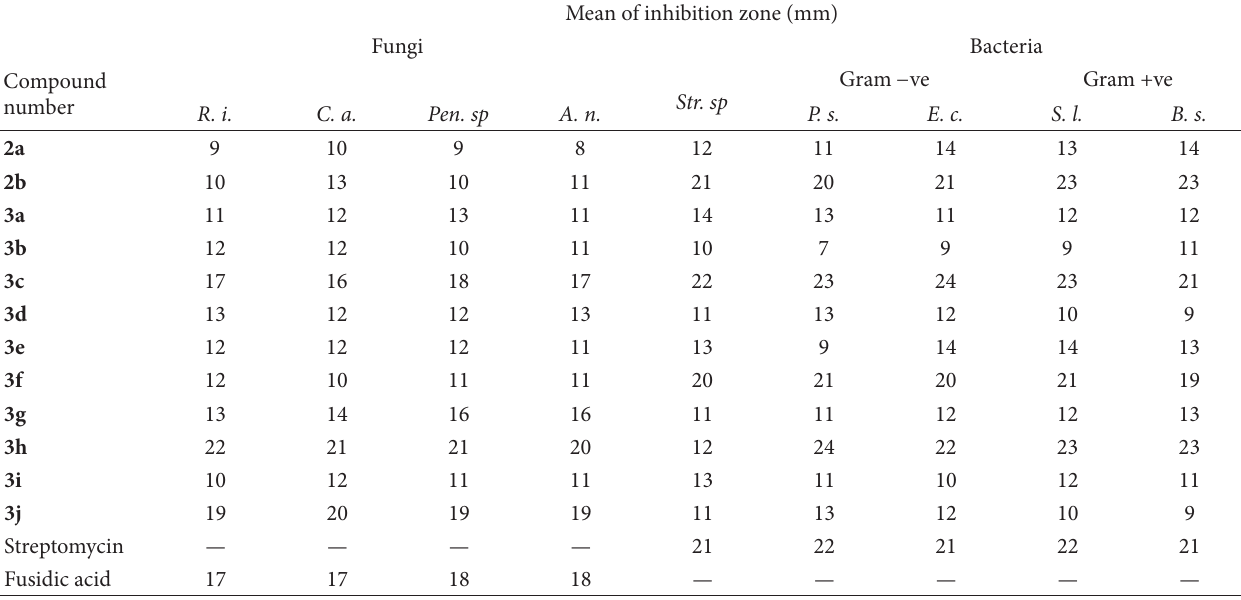
T 1: Antimicrobial activity of the newly synthesized compounds. Mean of inhibition zone (mm) Fungi Bacteria